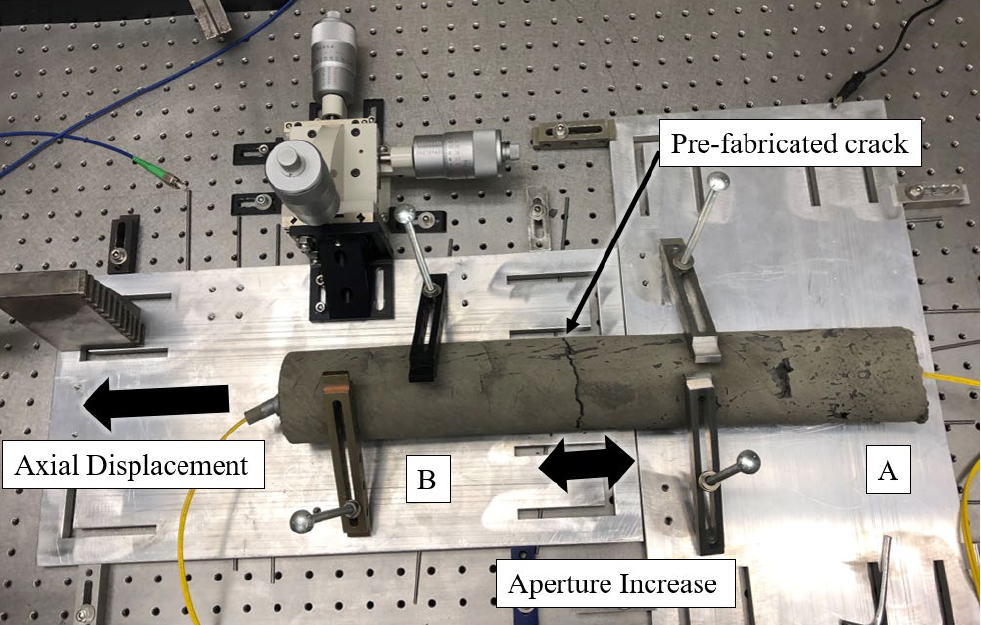
Figure 10. Sliding plates are set up for the administration of axial displacements upon a cylindrical cement beam with embedded fiber optic cables. The test setup is designed to simulate the opening of a discontinuity surface along a borehole trace in which a DOFS is installed within grout or some form of brittle media. A and B denote the fixed and moving sides, respectively.